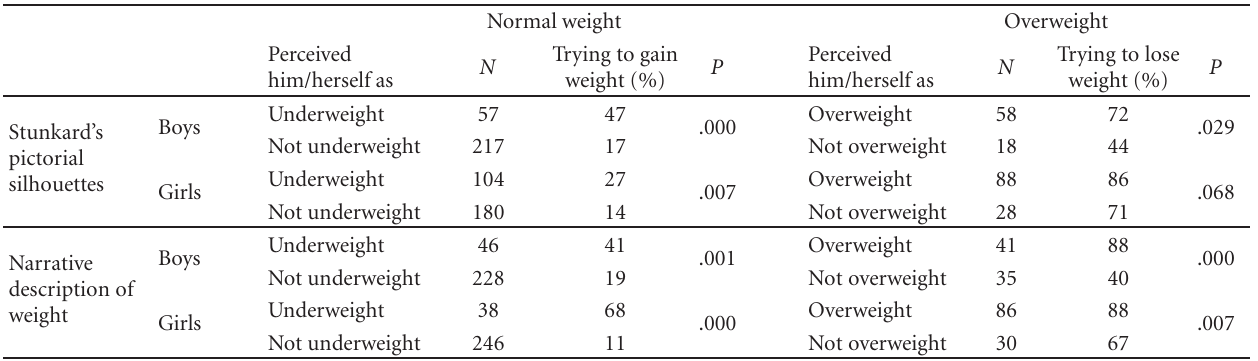
Table 4: Association between self-perceived weight and weight-control behavior among normal-weight and overweight boys and girls. Normal